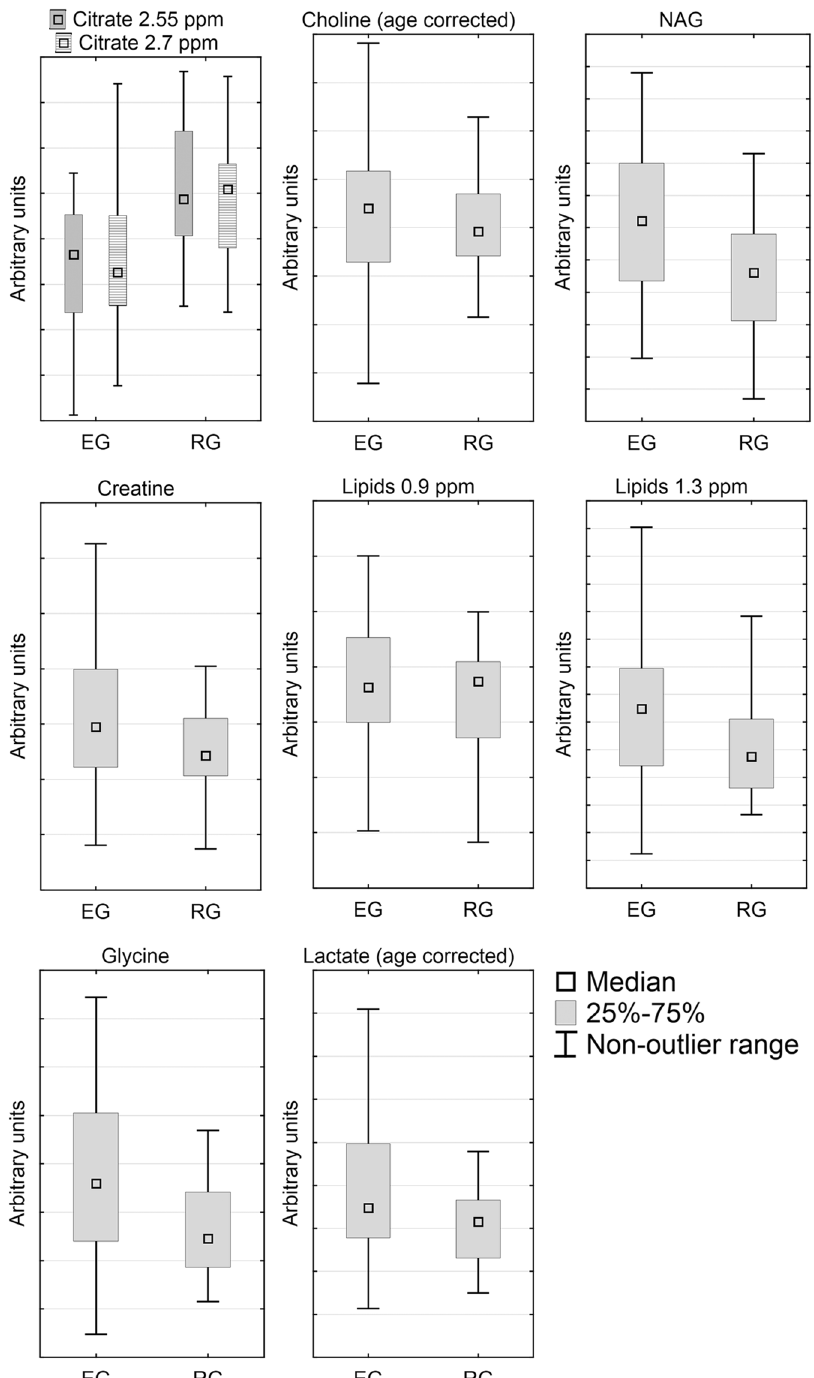
Figure 4. The box plot representation of the relative changes in the significant metabolites identified by the OPLS-DA model as important to discriminate between EG and RG groups. For choline and lactate only the age corrected values are